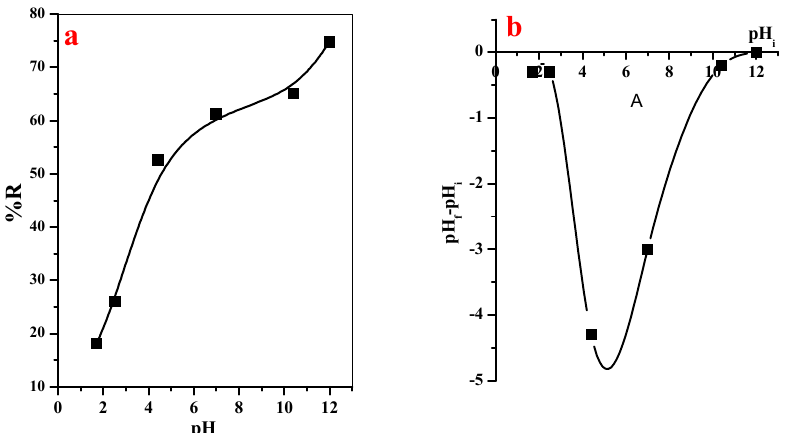
a linear increase in the adsorption efficiency from 18.1 to 74.8%. This is because, in acidic